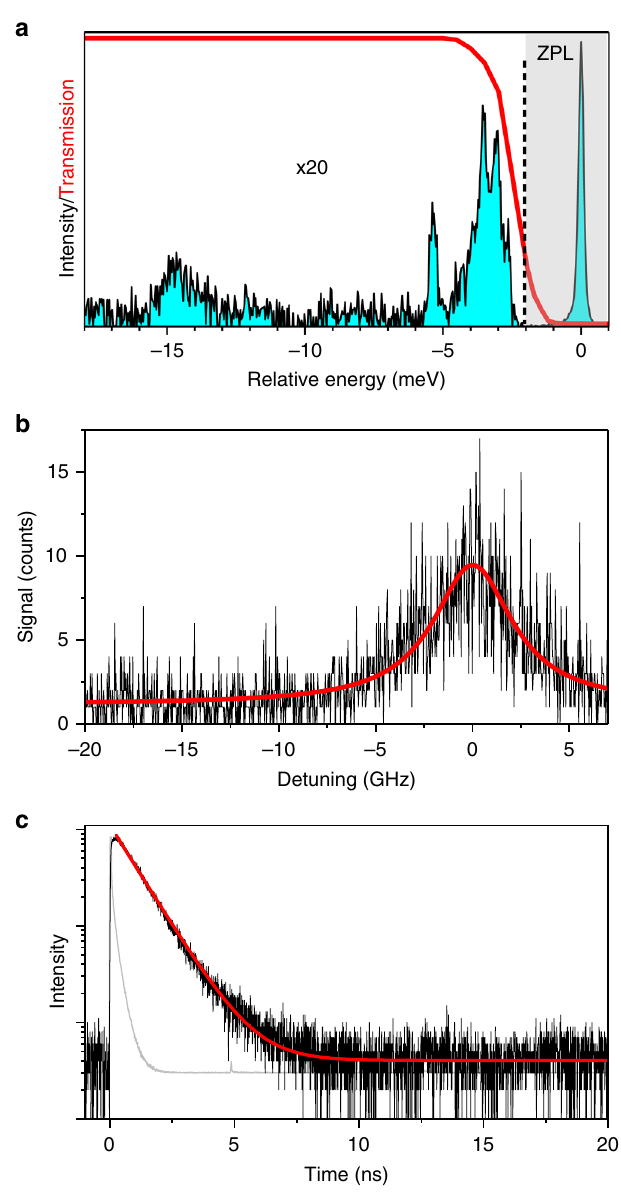
Fig. 4 Measurement of the exciton optical coherence lifetime. a Low- temperature PL spectrum of a NC presenting a single ZPL. The origin of the energy scale is taken at the ZPL. The low-energy part of the spectrum is magni fi ed by a factor of 20. Six LO phonon modes are identi fi ed with phonon energies 3.0, 3.5, 5.4, ~8, ~11, ~15meV. To record a resonant PL excitation spectrum, the frequency of a single-mode laser is scanned across a ZPL, while photons emitted on the highest phonon-energy LO phonon sidebands are collected through a low-pass fi lter (transmission curve illustrated by the red line). b Resonant PL spectrum built from a sum of 9 scans (1s per scan, 1ms per bin), with an excitation intensity of 20W cm − 2 . It is fi tted with a Lorentzian pro fi le (red curve) with a FWHM linewidth of 5GHz. c Typical PL decay of a single NC, for an average number of exciton per pulse 〈 N 〉 = 0.2. The red curve is an exponential fi t with a lifetime of 1.0 ns. The instrument response function is shown in